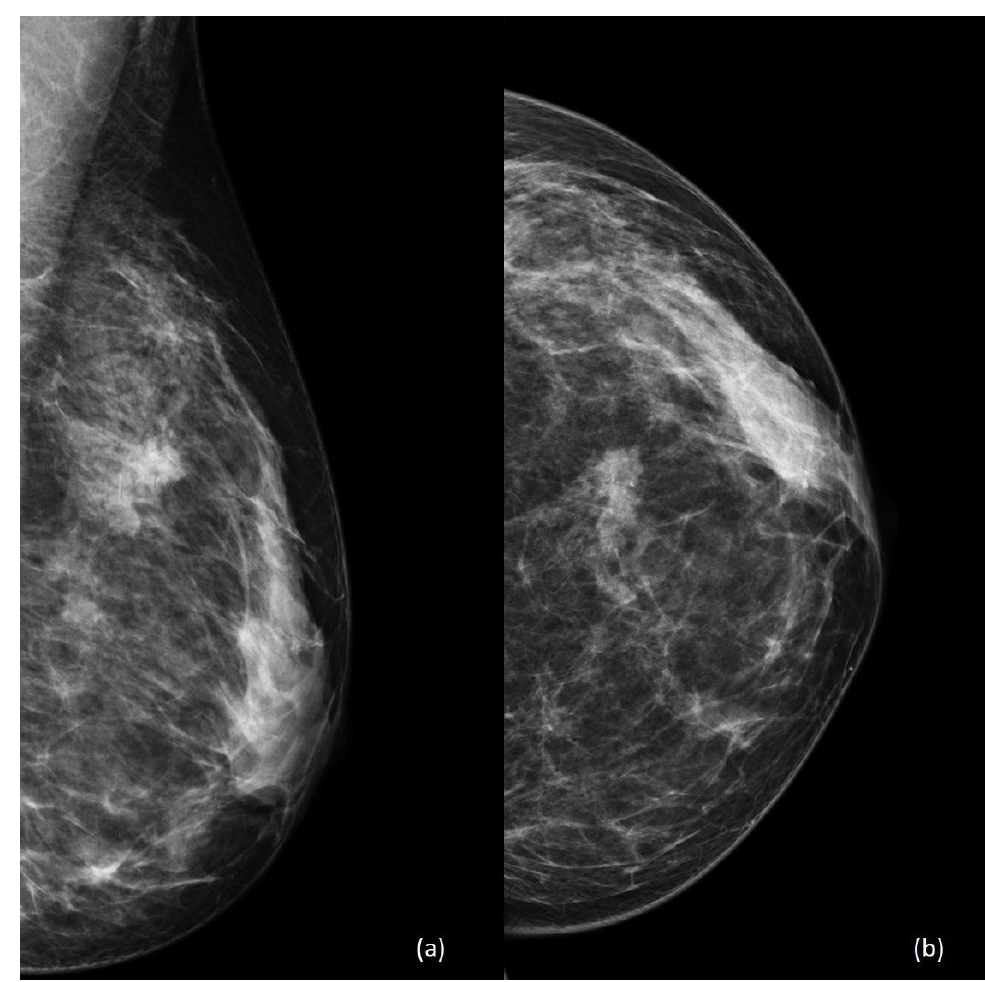
Figure 2. A 42-year-old patient, seventh week of pregnancy. Standard mammography including ( a ) mediolateral oblique view and ( b ) craniocaudal view of the left breast.